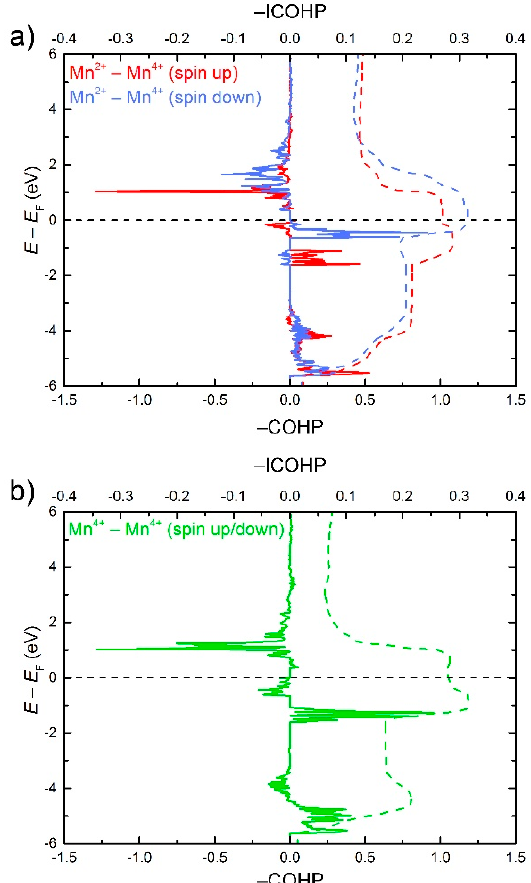
Figure 6. LSDA electronic density of states for Ba 4 [Mn 3 N 6 ] in the AFM1 structure. Positive and negative DOS values correspond to major and minor spin channels, respectively.